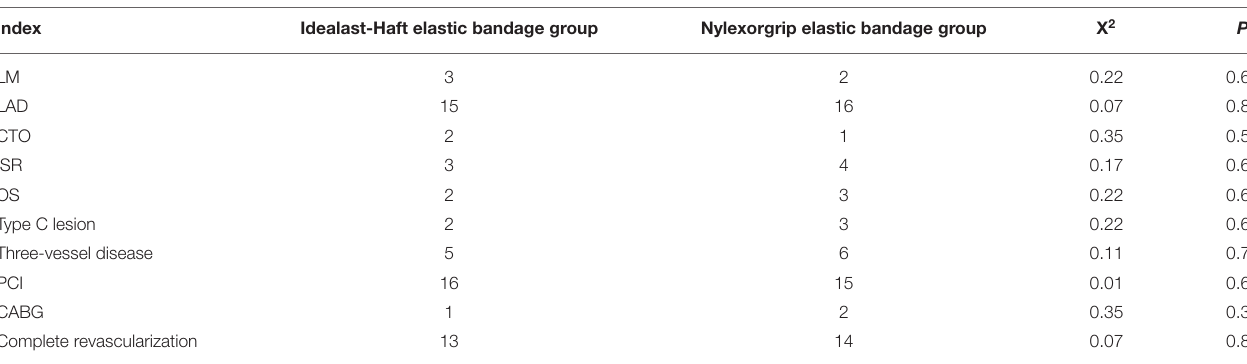
TABLE 4 | Results of coronary angiography (number of cases,